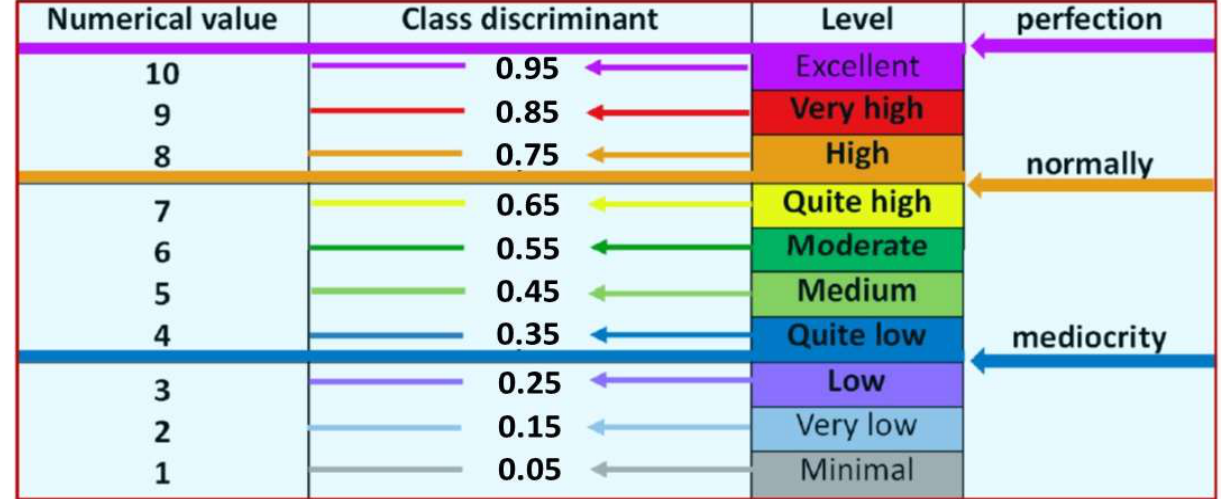
Figure 6. The Universal Relative State Scale.